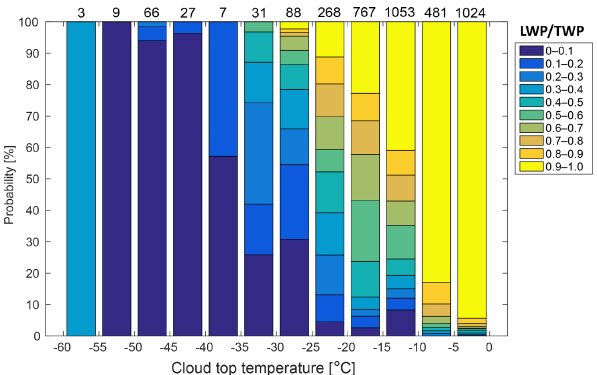
Figure 12. The relative probabilities of different ranges of the liq- uid fraction LWP / TWP given at various cloud-top temperatures of single-layer mixed-phase clouds. The probability is normalized by the total number of profiles for each cloud-top temperature range. Numbers at the top of plot show the number of cases included in the temperature range. The total number of profiles is